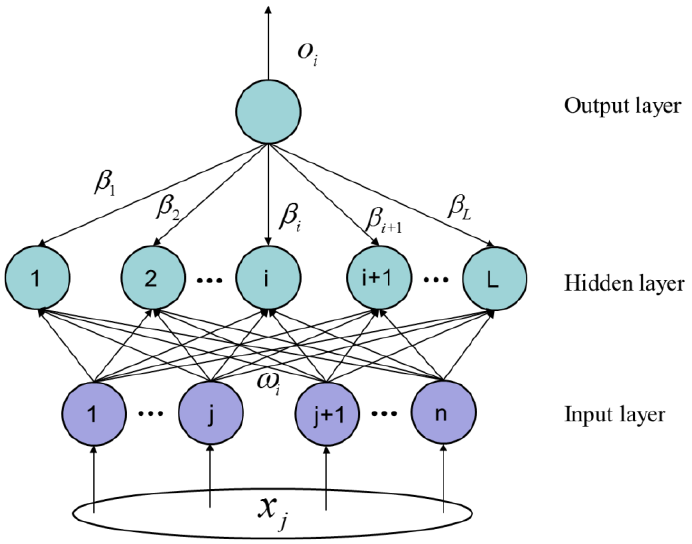
Figure 9. SLFN network model.